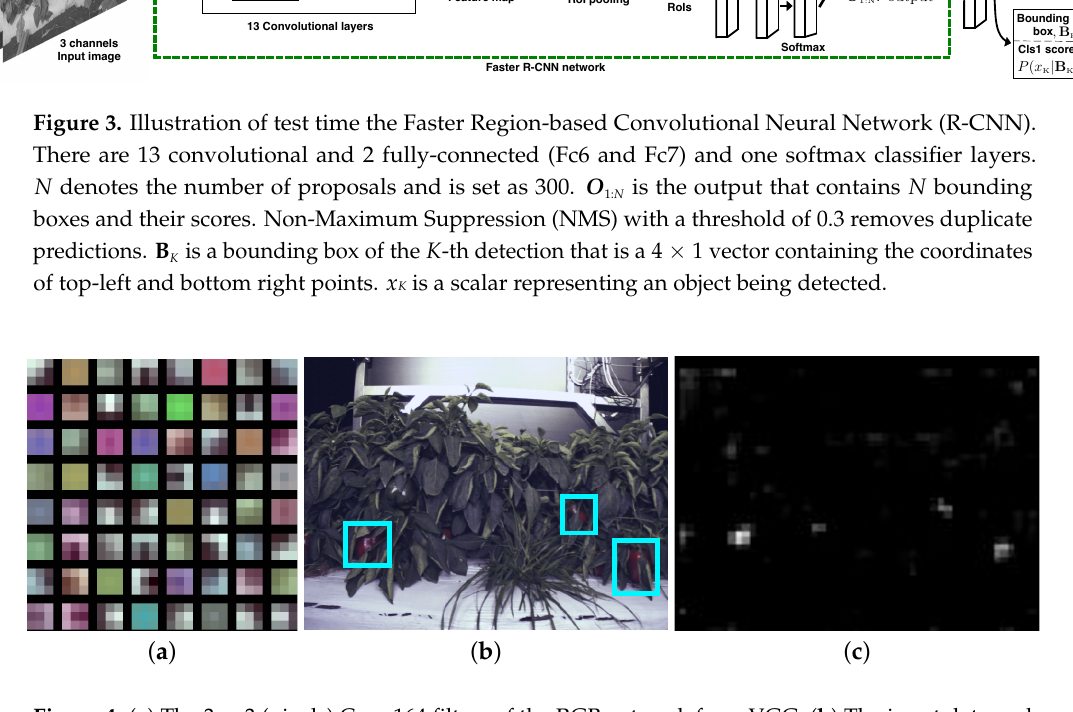
Figure 4. ( a ) The 3 3 (pixels) Conv164 filters of the RGB network from VGG, ( b ) The input data and × ( c ) One of the feature activations from the conv5 layer. The cyan boxes in (b) are manually labelled in the data input layer to highlight the corresponding fruits of the feature